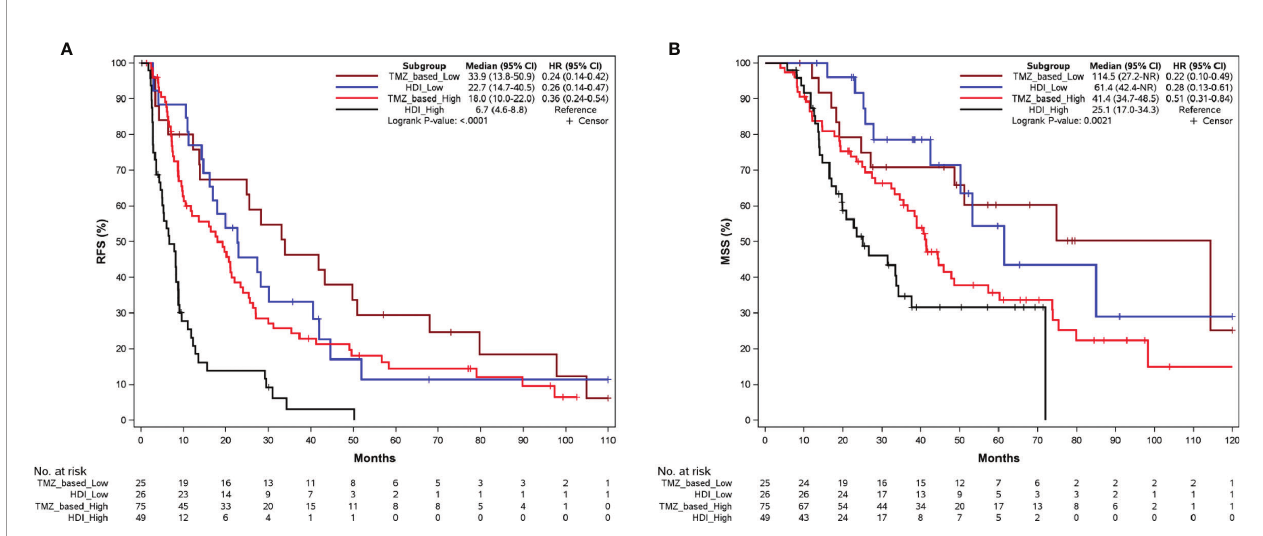
FIGURE 4 | Kaplan-Meier curves of RFS (A) and MSS (B) according to adjuvant regimens in patients in the Ki67 low (<30%) and Ki67 high (>=30%) group. RFS, relapse-free survival; MSS, melanoma-speci fi c survival; TMZ, temozolomide; HDI, high-dose